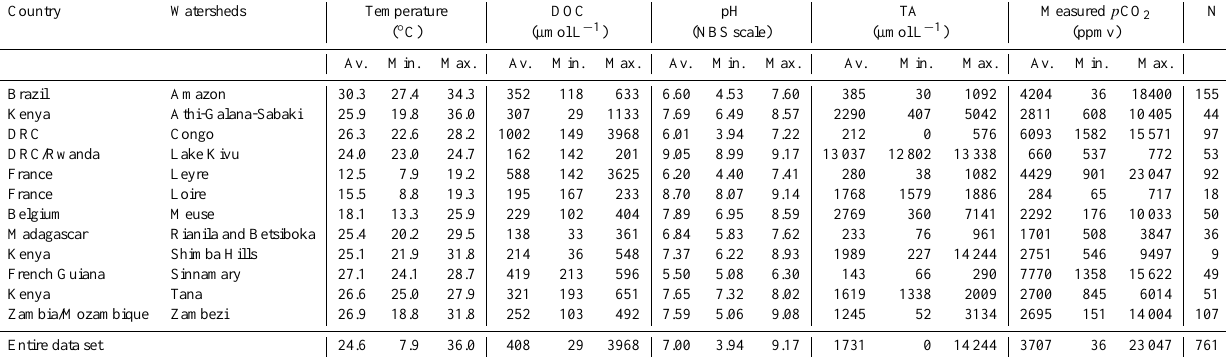
Table 1. Summary of the presented data set. Average, minimum, and maximum values of temperature, DOC, pH (measured on the NBS scale), total alkalinity (TA), and measured partial pressure of CO 2 ( p CO 2 ) in the different freshwater ecosystems.